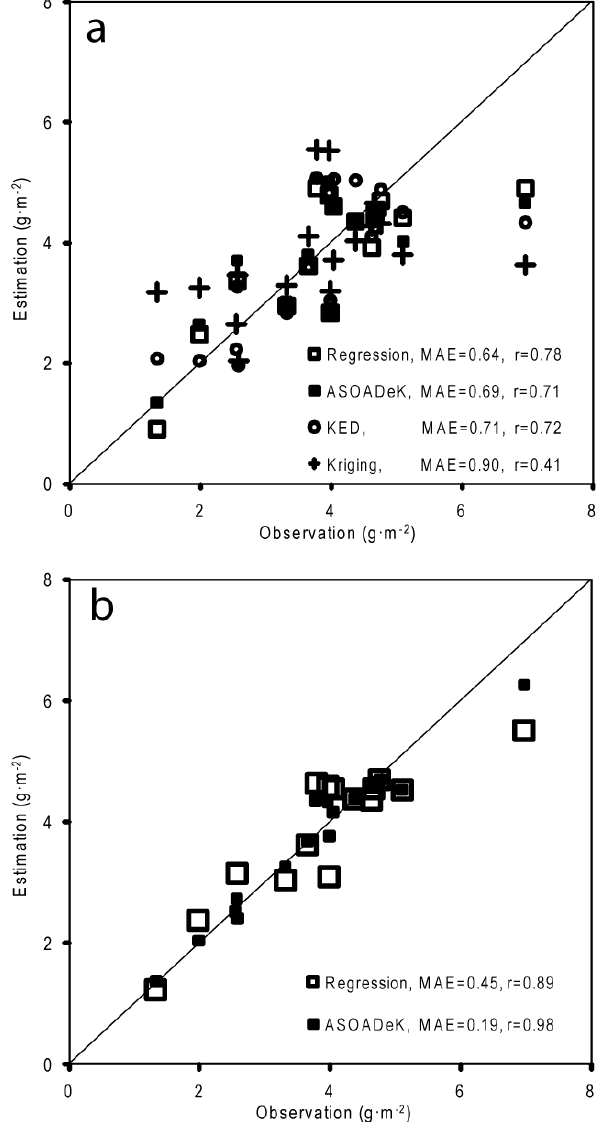
Fig. 5. (a) Cross-validation estimates of annual bulk chloride depo- sition from regression, ASOADeK, KED, and direct ordinary krig- ing, and (b) regression estimates of annual bulk chloride deposition (for the 15 sites) and ASOADeK estimates (for all 17 sites), in com- parison to the observations. The MAE values are mean absolute er- rors (gm − 2 ) of the observation sites, and the r-values are Pearson correlation coefficients between the estimates and the